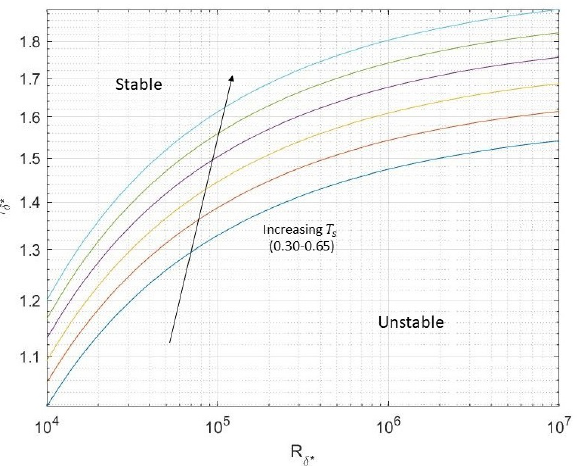
Figure 11. Plot illustrating predictions of asymptotic neutral wavenumber γ δ ∗ against R δ ∗ for type I modes for T s = 0.30 − 0.65. Larger T s values move the plots up as shown by the arrow.